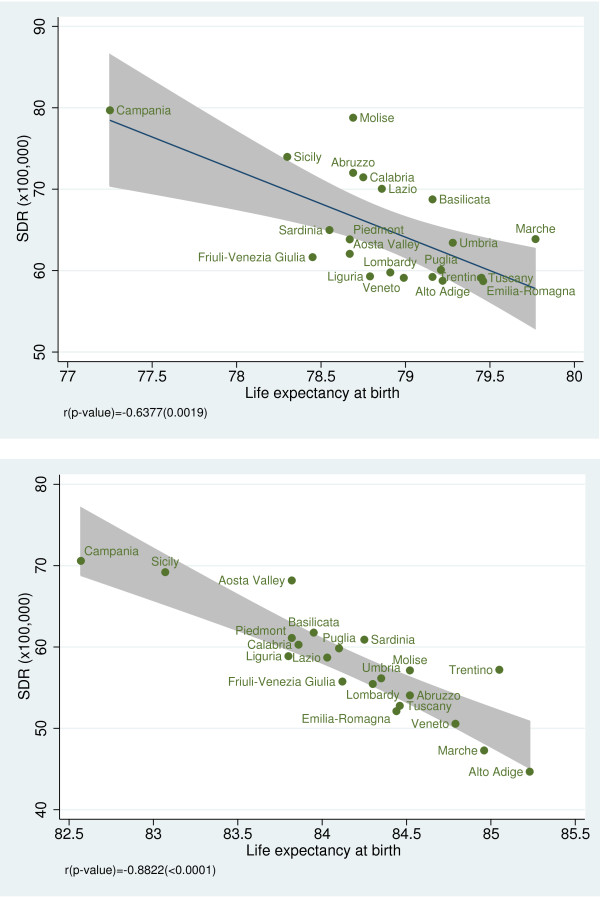
a. Amenable mortality vs. life expectancy at birth (males) for the year 2008 (males). Data source: Health for All 2011 [19]. b. Amenable mortality vs. life expectancy at birth (females) for the year 2008. Data source: Health for All 2011 [19].